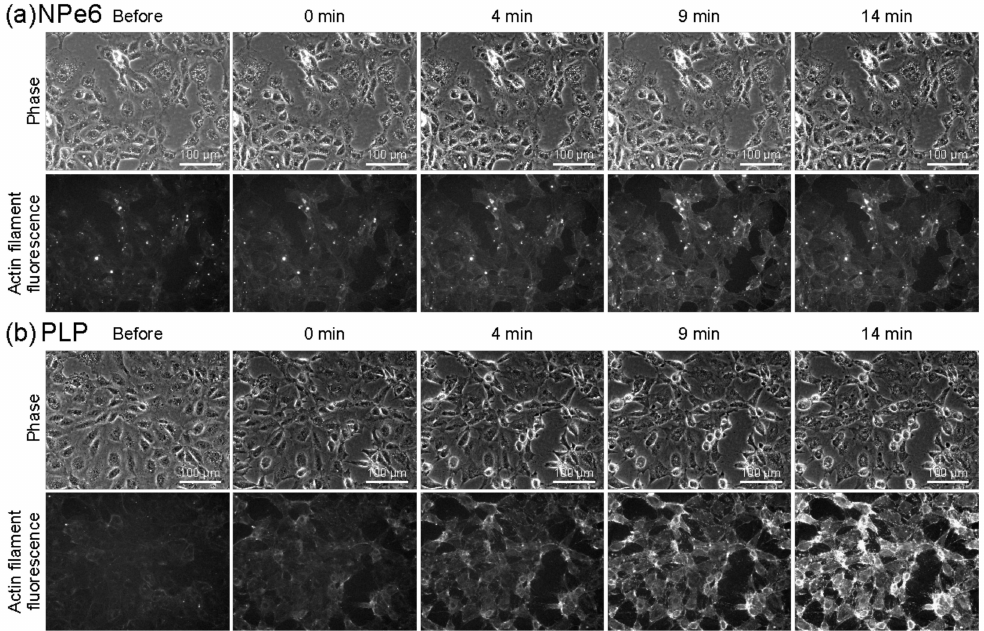
Figure 3. Results of time-lapse observation with a fluorescence microscopy. NPe6 ( a ) and PLP ( b )-doped RGK1 samples were allowed to stand for 24 h in an incubator and then irradiated with a light of 34 mW/cm 2 at a wavelength of 655 nm for 1 min.